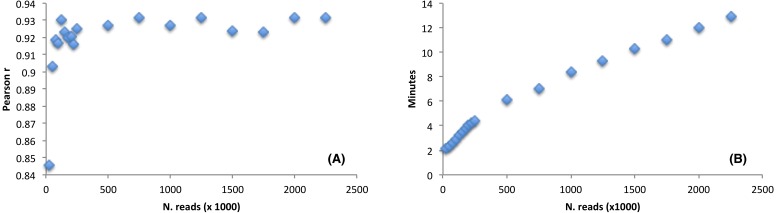
The effect of the initial dataset size on the favoured codons detection and running time.(A) Pearson correlation between the codons odds ratio calculated with corseq and the classical expression method. For each point, the corseq odds ratio values were calculated starting from RNAseq dataset of different size. (B) Computational times of the corseq elaboration for RNAseq dataset of different size.